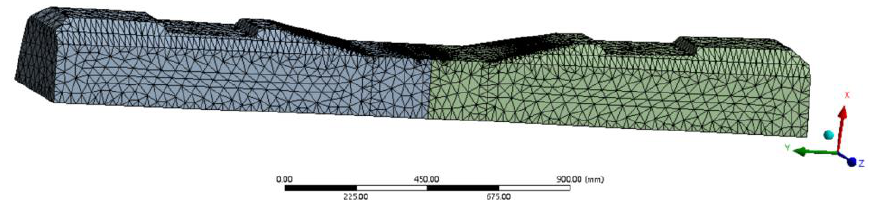
Figure 1. Prestressed concrete sleeper model. Table 2. Material properties of the prestressed concrete sleeper.